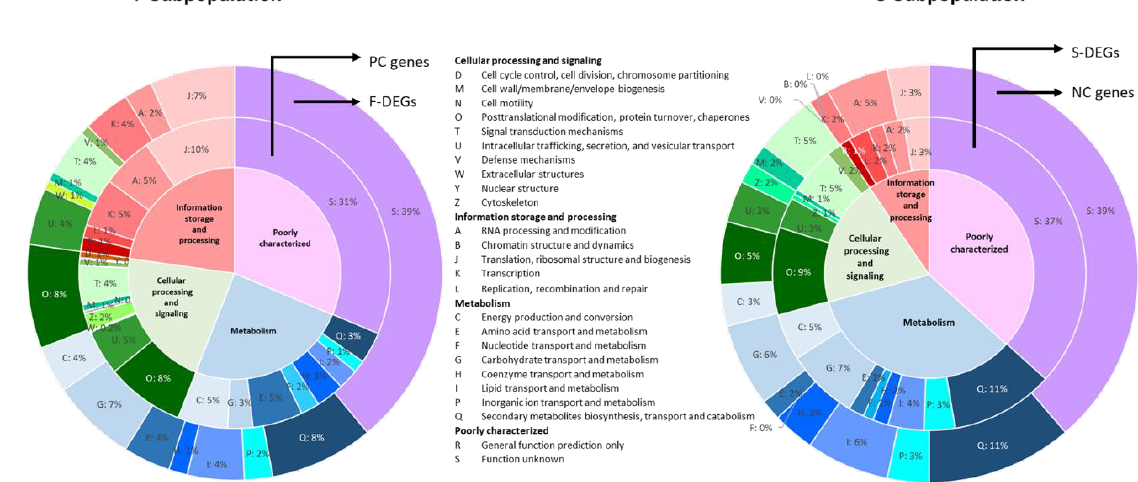
Figure 3. Eukaryotic Orthologous Group (KOG) classification representing 25 KOG functional categories. The numbers in the picture indicate the percentage of genes assigned to each KOG category in this study. The order of the inner and outer circles in both graphs were made based on the best fit with the central circle.